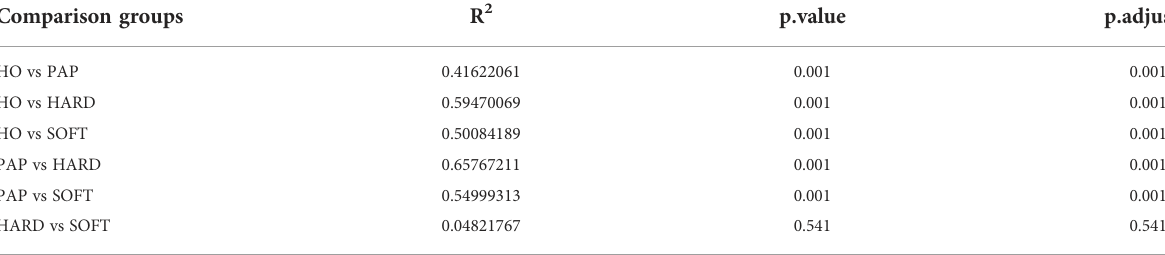
TABLE 2 PERMANOVA pairwise comparison based on unweighted unifrac distance. Comparison